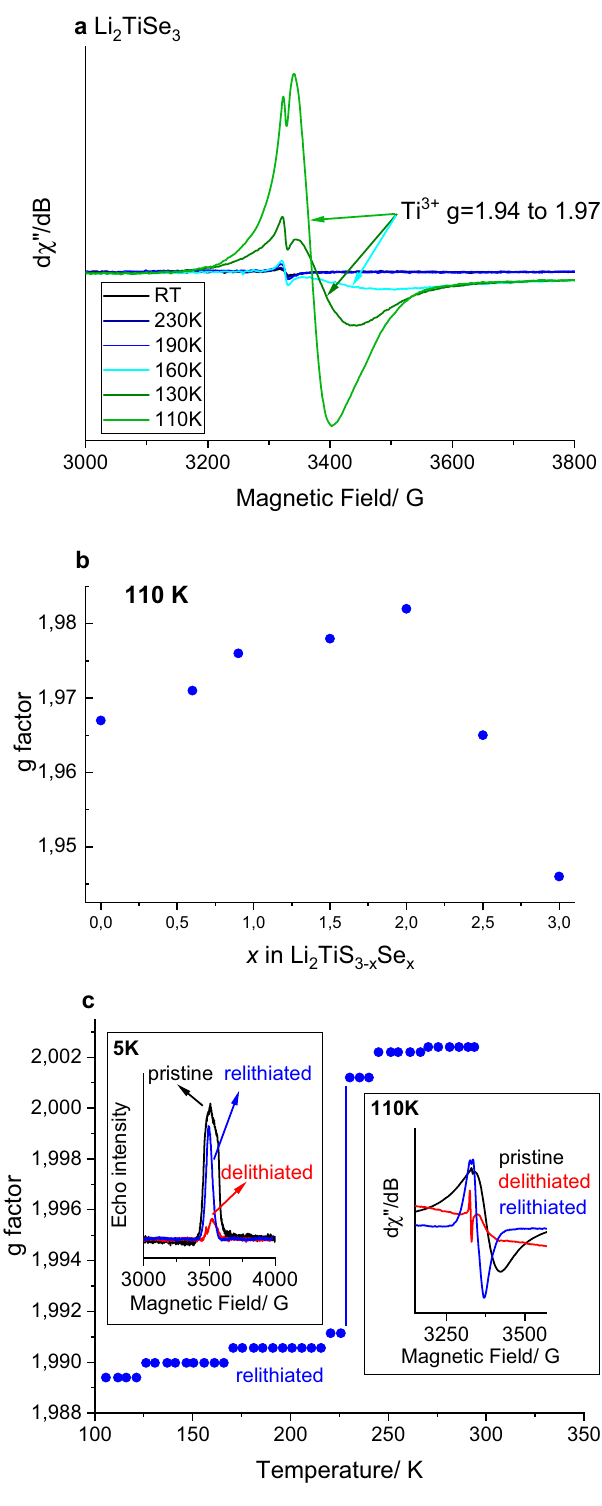
Fig. 5 EPR results on Li 2 TiS 3 − x Se x . a Temperature-dependent EPR spectra of Li 2 TiSe 3 ( b ) evolution of the g -factor in Li 2 TiS 3 − x Se x at 110 K. c Main: temperature dependence of the g -factor of relithiated Li y TiS 2.4 Se 0.6 . Inset: EPR spectra of pristine Li 2 TiS 2.4 Se 0.6 (black), delithiated Li y TiS 2.4 Se 0.6 (red) and relithiated Li y TiS 2.4 Se 0.6 (blue) at 5 and 110 K,